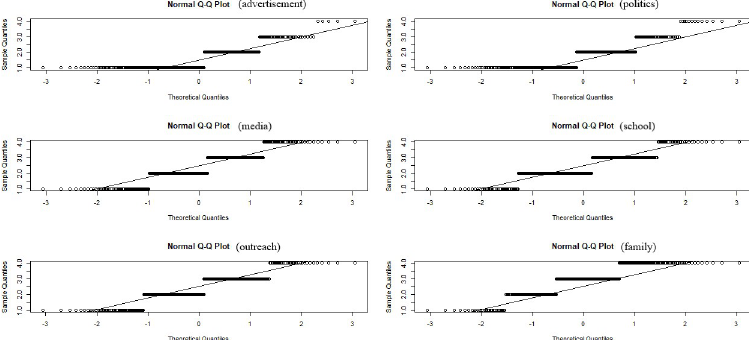
Fig 4. All Q-Q plot graphics of EE sources show a normally distributed data based on the Likert-scale.